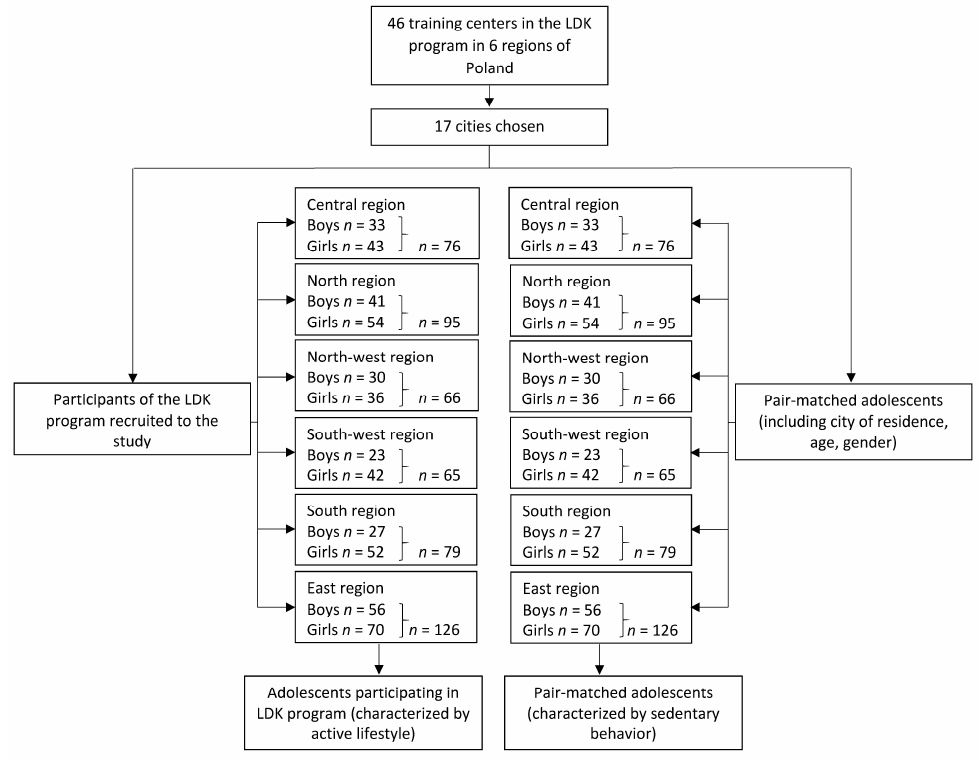
Figure 1. The number of participants of the study from each region of Poland. LDK, Lekkoatletyka Dla Ka ż dego.